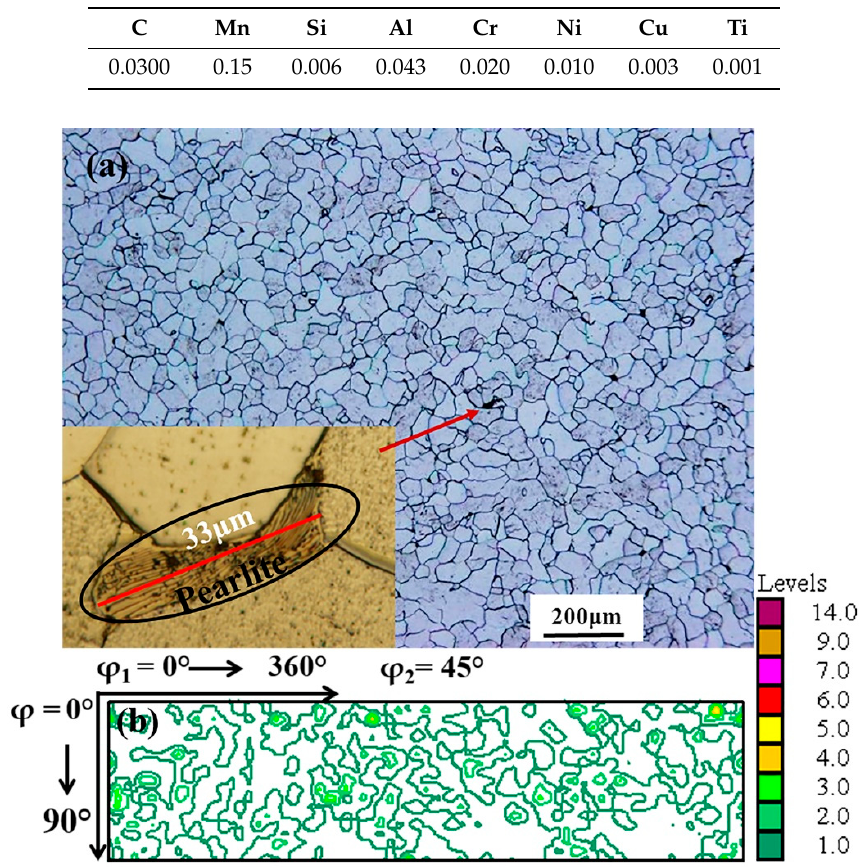
Figure 1. ( a ) Microstructure and ( b ) texture of extra ‐ low carbon steel sheet after heat treatment, before